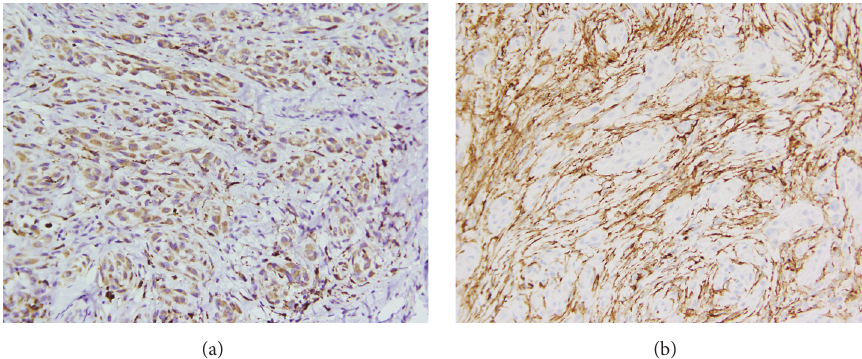
Figure 3: Immunohistochemical study. Immunohistochemical staining for (a) CD68, diffusely positive in epithelioid or histiocyte-like cells, and (b) CD34, diffusely positive in spindle or fibroblast-like cells ( × 200